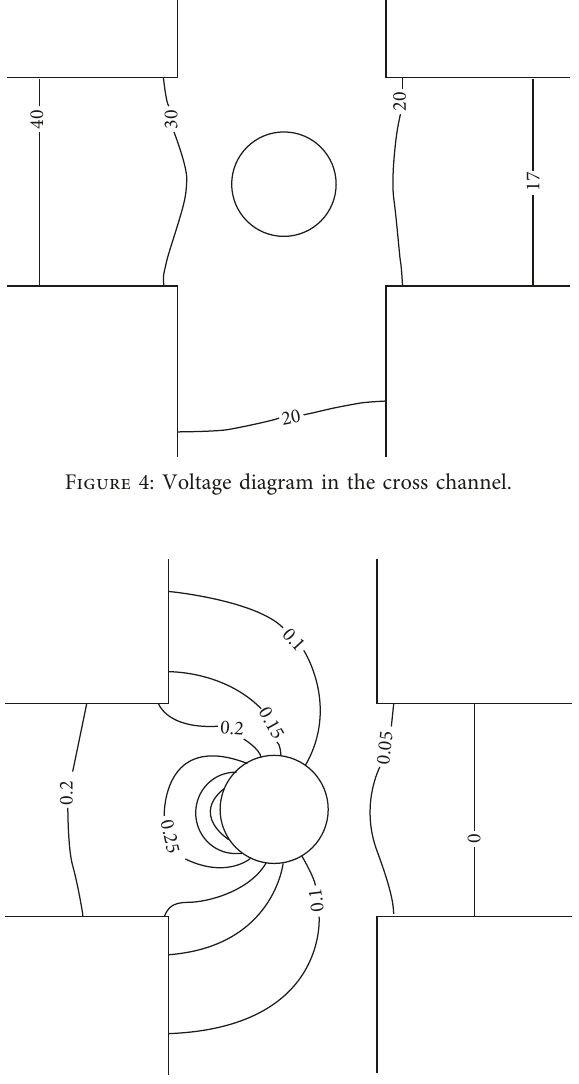
Figure 5: Charge density diagram the in cross